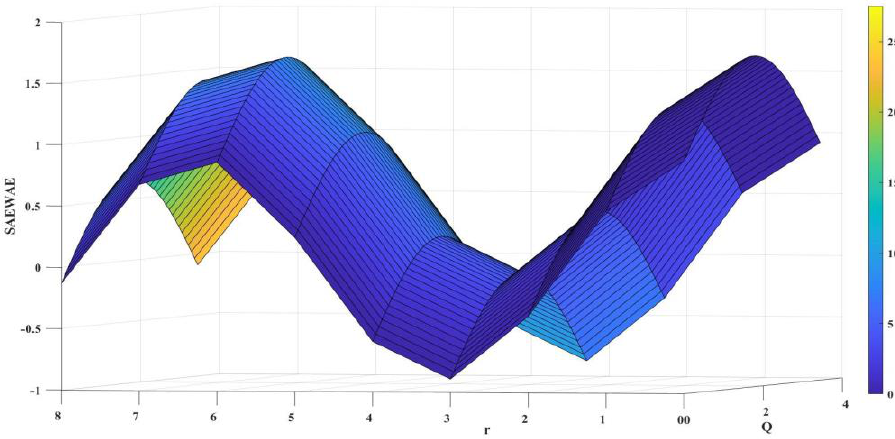
Figure 15. 3D curve of optimizing adaptive parameters for CCHIF.